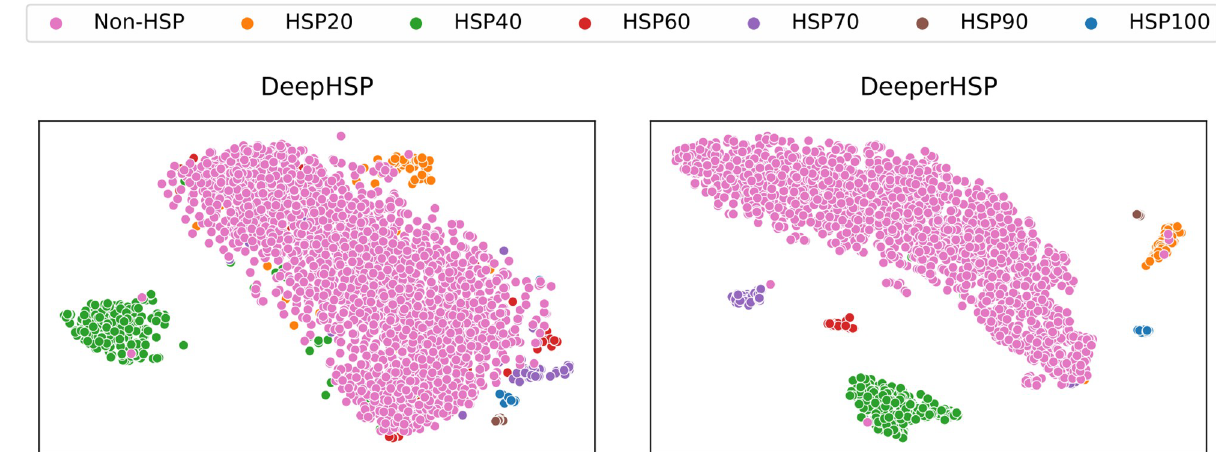
Fig 2. t-SNE plot of the latent representations of DeepHSP and DeeperHSP for the cross-validation dataset.